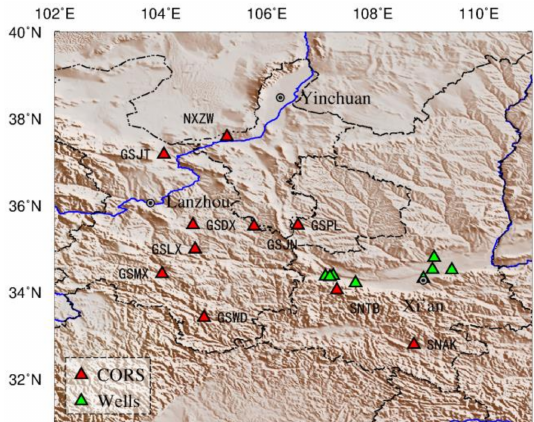
Figure 1. Location of CORS stations and wells for monitoring groundwater level in the SGN